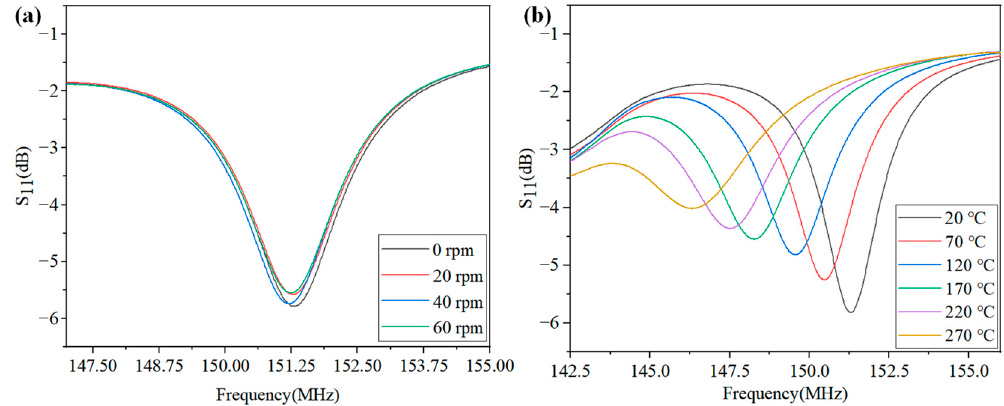
Figure 6. ( a ) S 11 -frequency characteristic curve at different speeds; ( b ) S 11 -frequency characteristic curve at different temperatures.